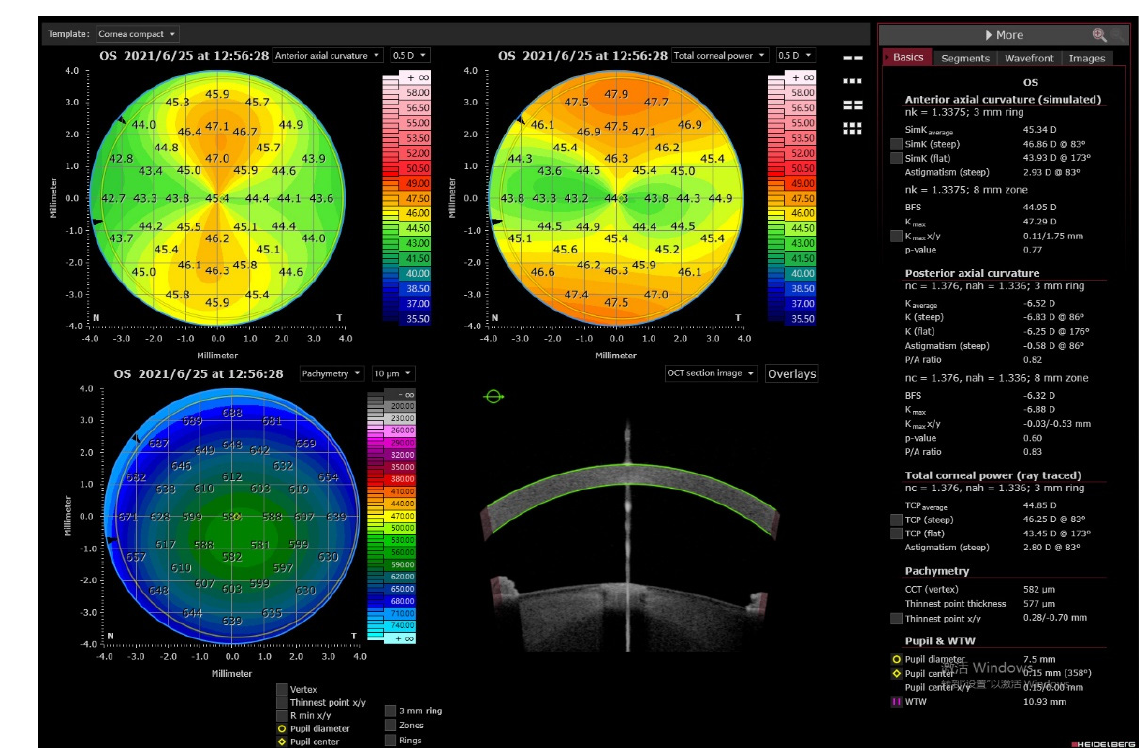
Figure 4. Corneal tomography in a swept-source optical coherence tomography device, the Anterion (Heidelberg Engi- neering).